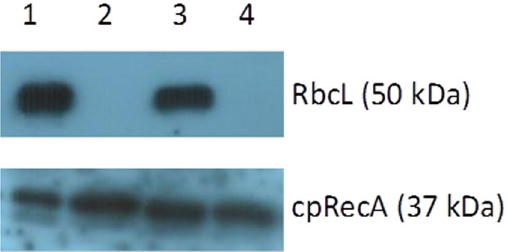
Figure 6. Immunoblot analysis of RbcL (upper) and cpRecA (lower) proteins in soluble protein extracts of albino and normal green seedlings from two different families. 20 µ g of proteins were loaded per lane. Lanes 1 and 2: normal green and albino siblings, respectively. Lanes 3 and 4: normal green and albino siblings, respectively.